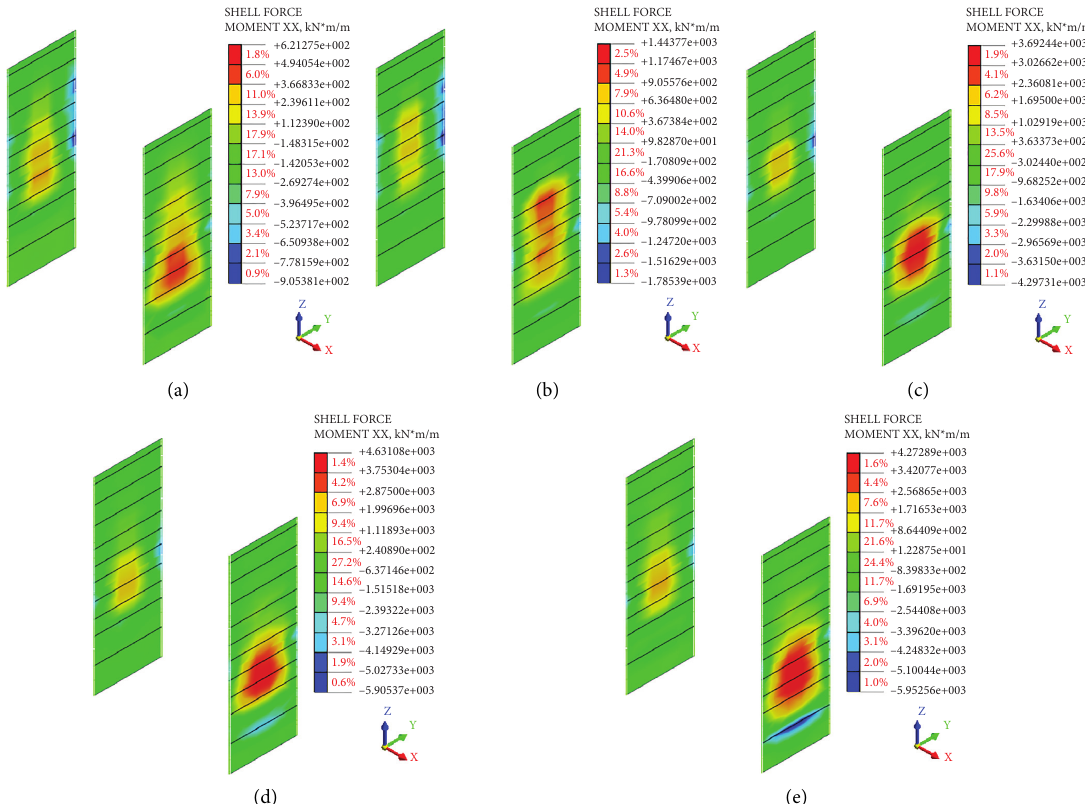
Figure 10: The bending moment contour plot of suspended diaphragm wall under five excavation step conditions. (a) The first excavation step. (b) The third excavation step. (c) The fifth excavation step. (d) The seventh excavation step. (e) The tenth excavation